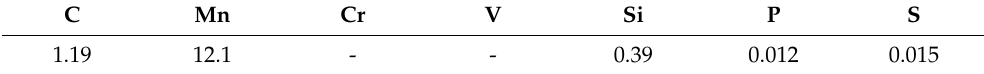
Table 1. Elemental composition of samples of Hadfield steel of 110G13L grade (wt.%).